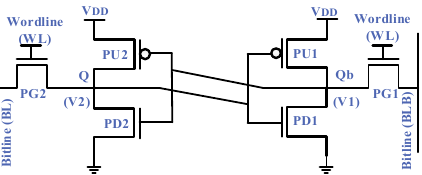
Figure 3. Conventional 6T-SRAM cell with: pull up (PU), pull down (PD) and pass gate (PG) transistors.